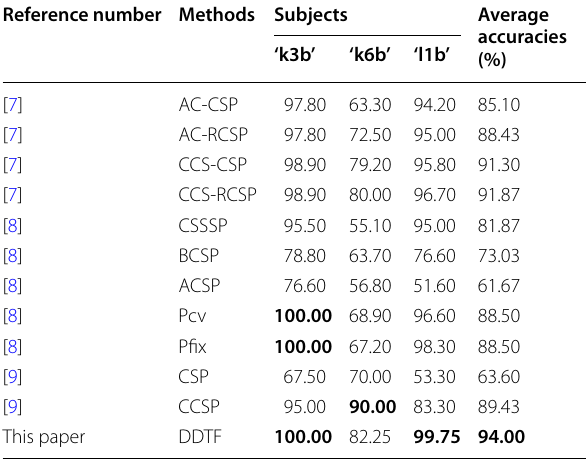
Table 3 Comparison with multiple CSP-based feature extraction methods